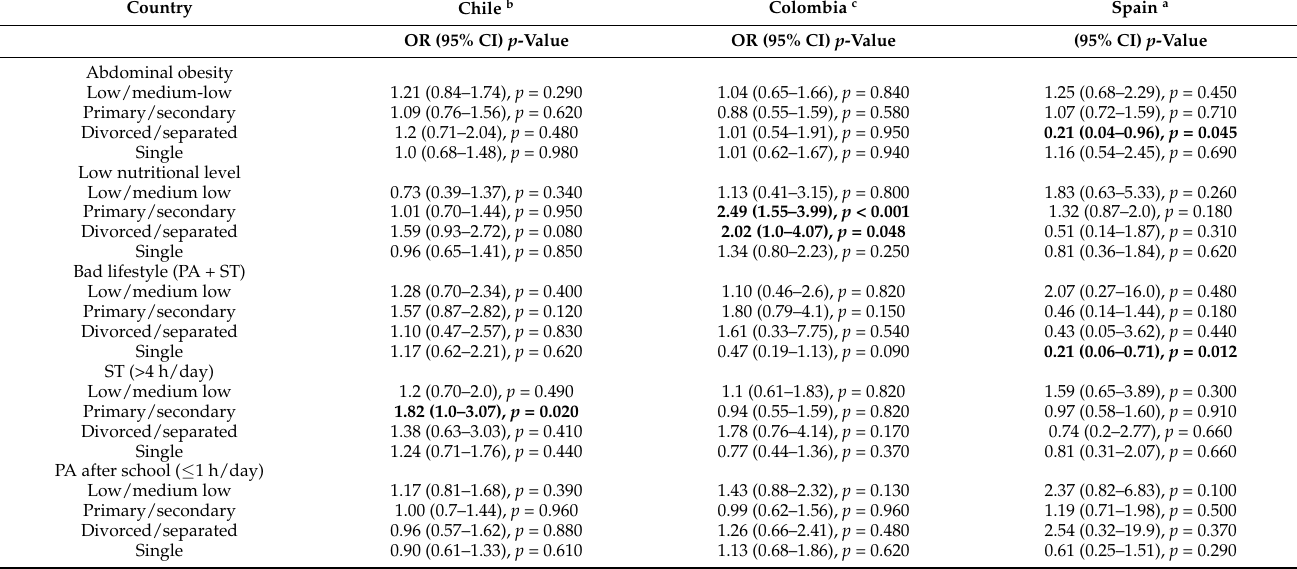
Table 4. Association between parental characteristics and AO, low nutritional level, and bad lifestyle in children. Country Chile b Colombia c Spain a OR (95% CI) p -Value OR (95% CI) p -Value (95% CI) p